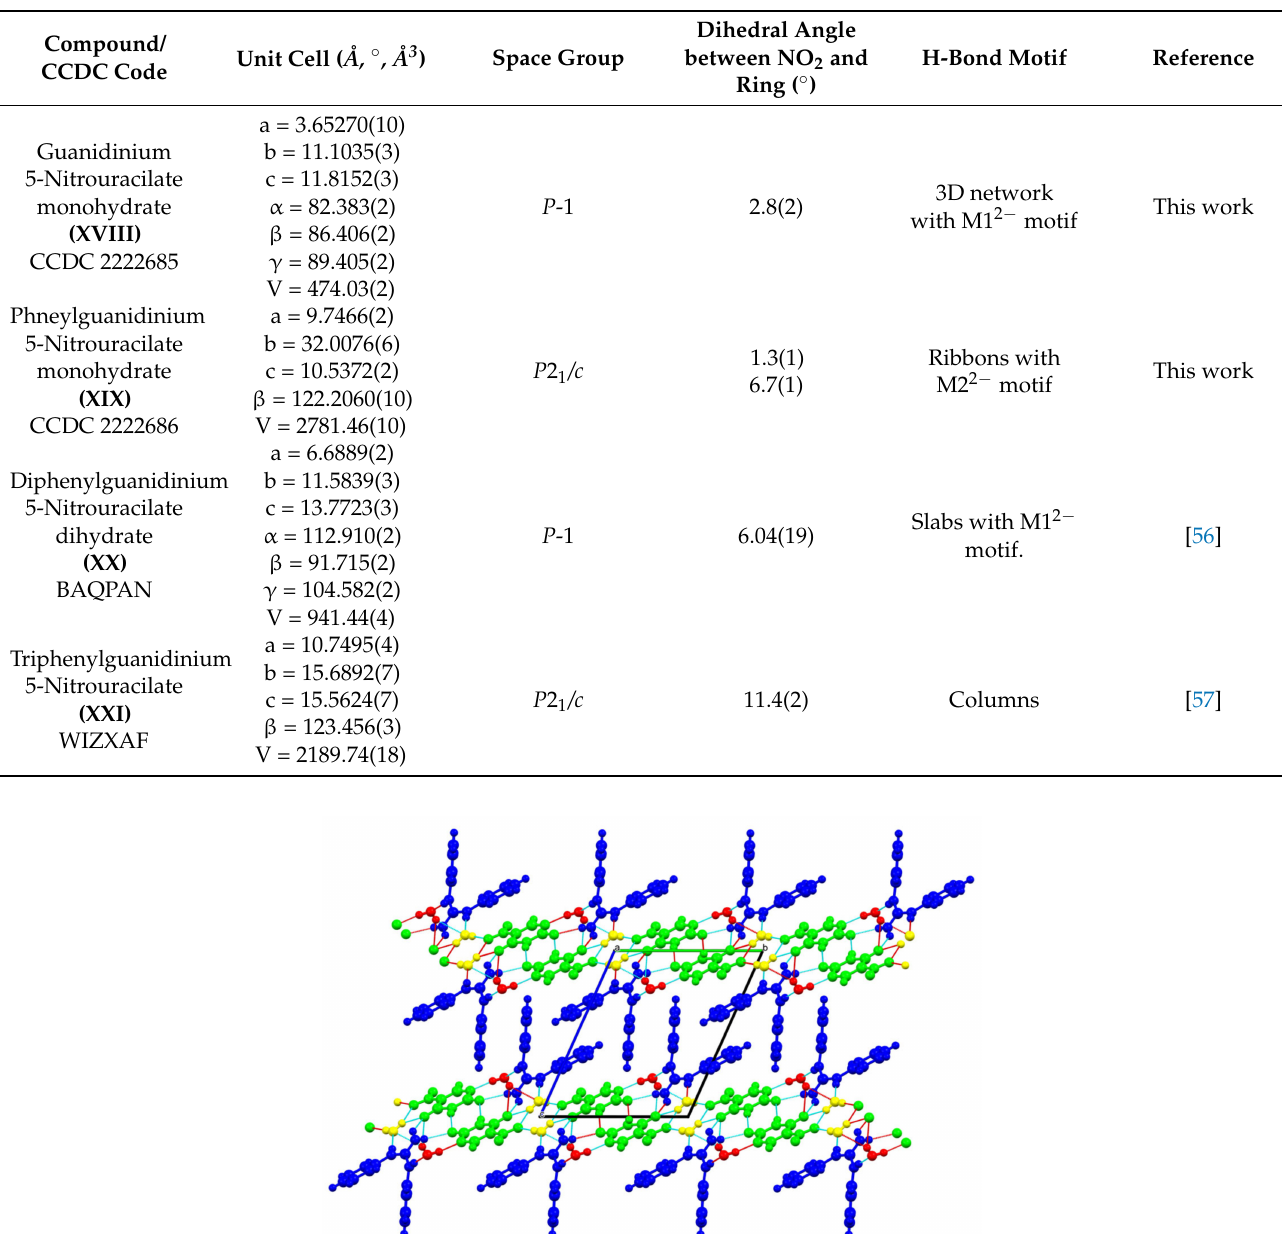
Table 10. Crystallographic data of 5NU salts of guanidine derivatives.